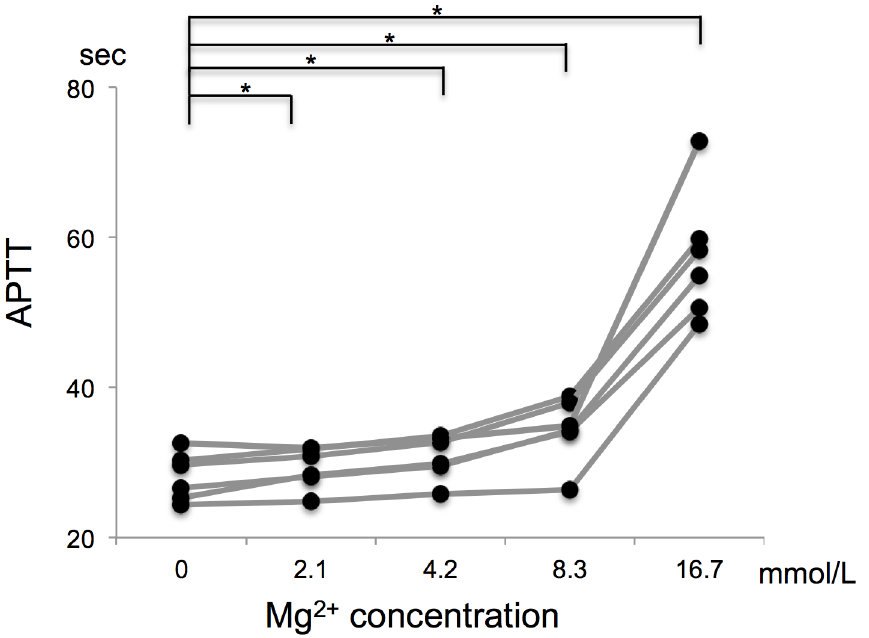
Fig 1. Effects of Mg 2+ on the APTT of normal subjects. * indicates a p -value of < 0.05